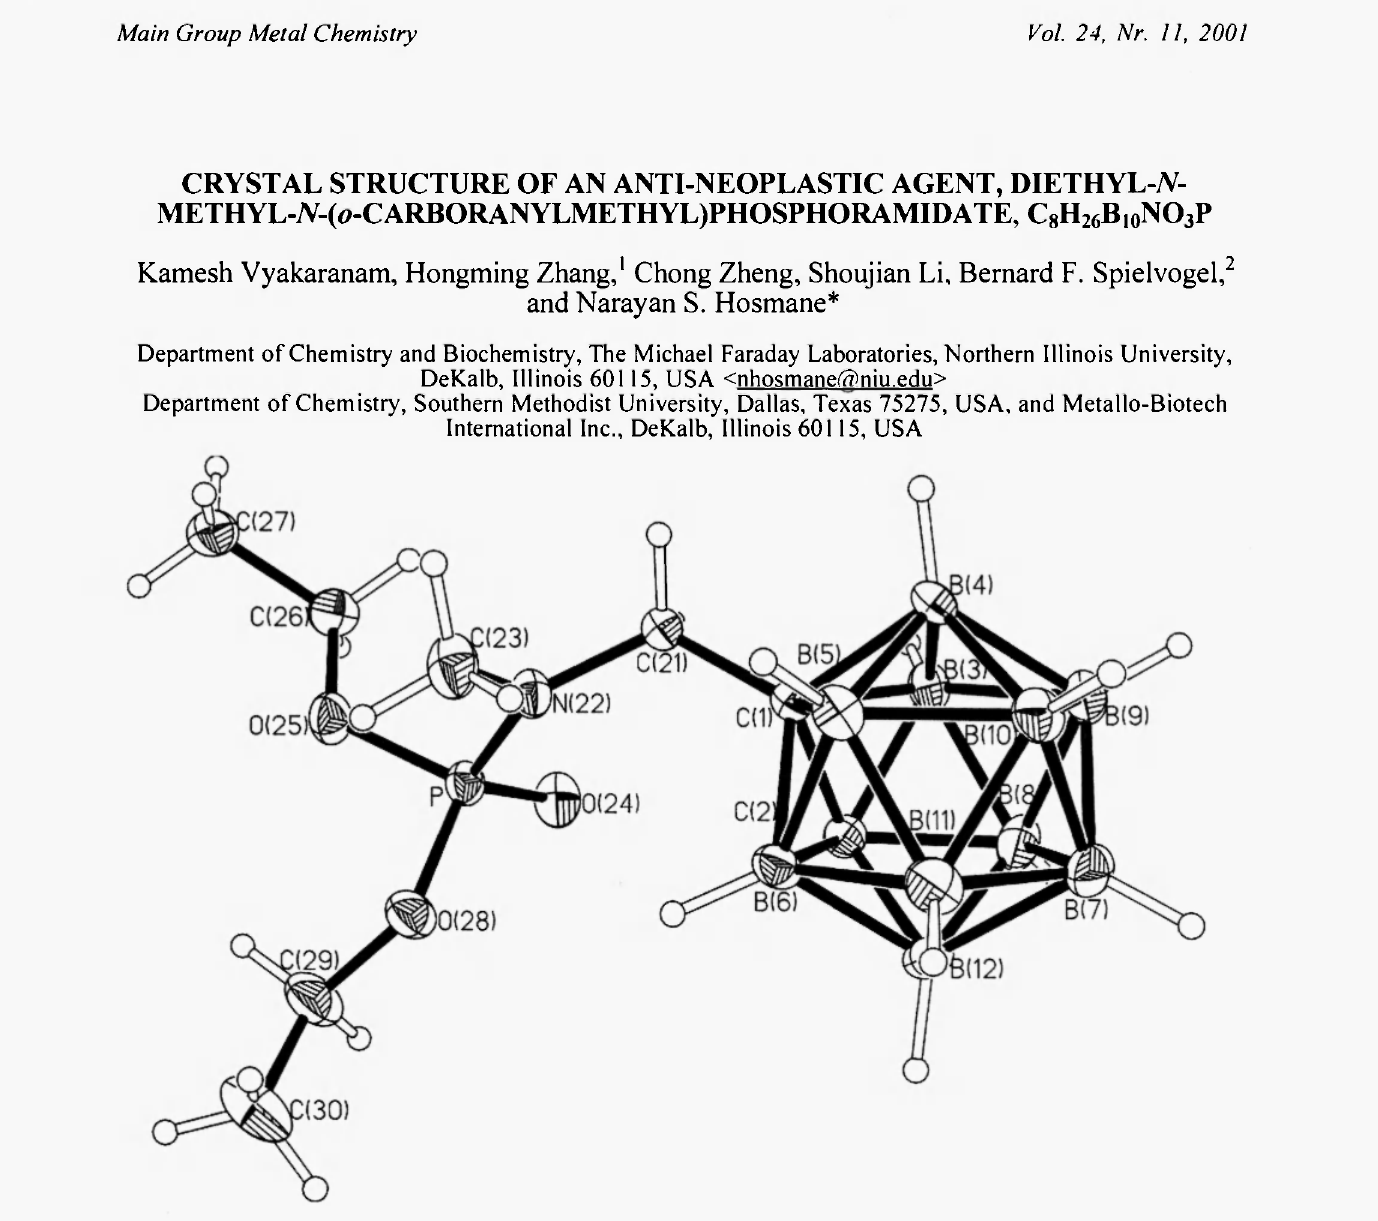
Figure 1. Molecular structure (50% displacement ellipsoids) of CgH^BioNOjP. The selected bond distances and angles in the exo-polyhedral moiety are: P-0(24) 1.464(2), P-0(28) 1.566(2), P-0(25) 1.580(2),